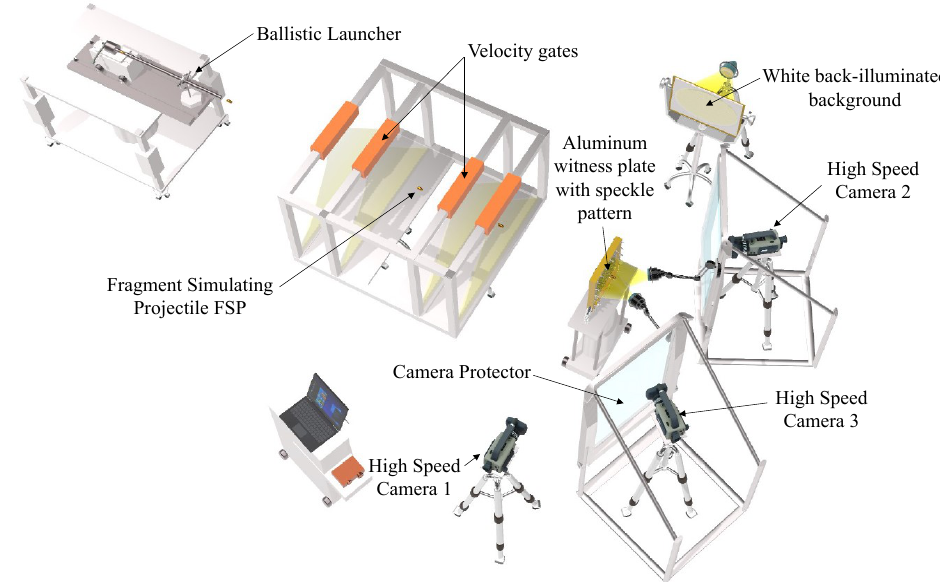
Figure 1. Schematic representation of the experimental setup for fragment impact loading using fragment-simulating projectiles (Video S1).